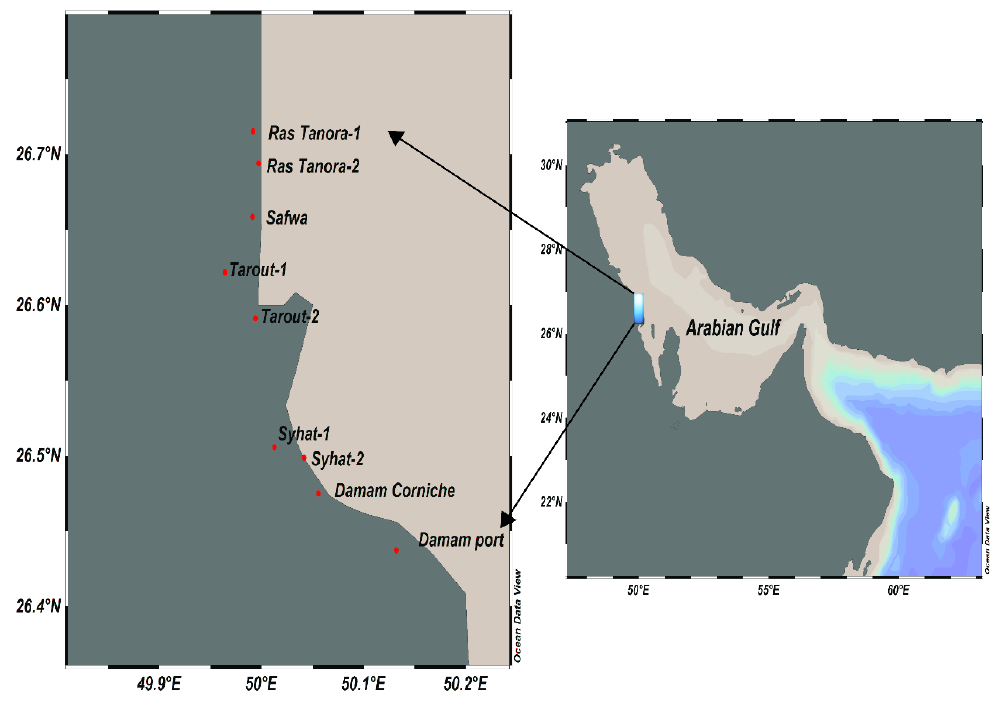
Figure 1: The map of the nine sampling locations of mangrove stands along Arabian